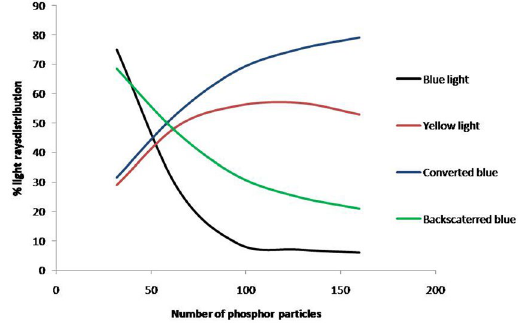
Figure 12. Blue and Yellow light rays distribution with varying number of phosphor particles. The black line represents the % of blue light rays out of the silicone. The blue line represented the % of blue light rays participated in the conversion to yellow light, which form part of the total decrease in the blue light rays. The green line represents the % of blue light rays scattered backward due to phosphor particles. The red line represents the ratio of the total yellow light rays emitted out of silicone expressed in %.